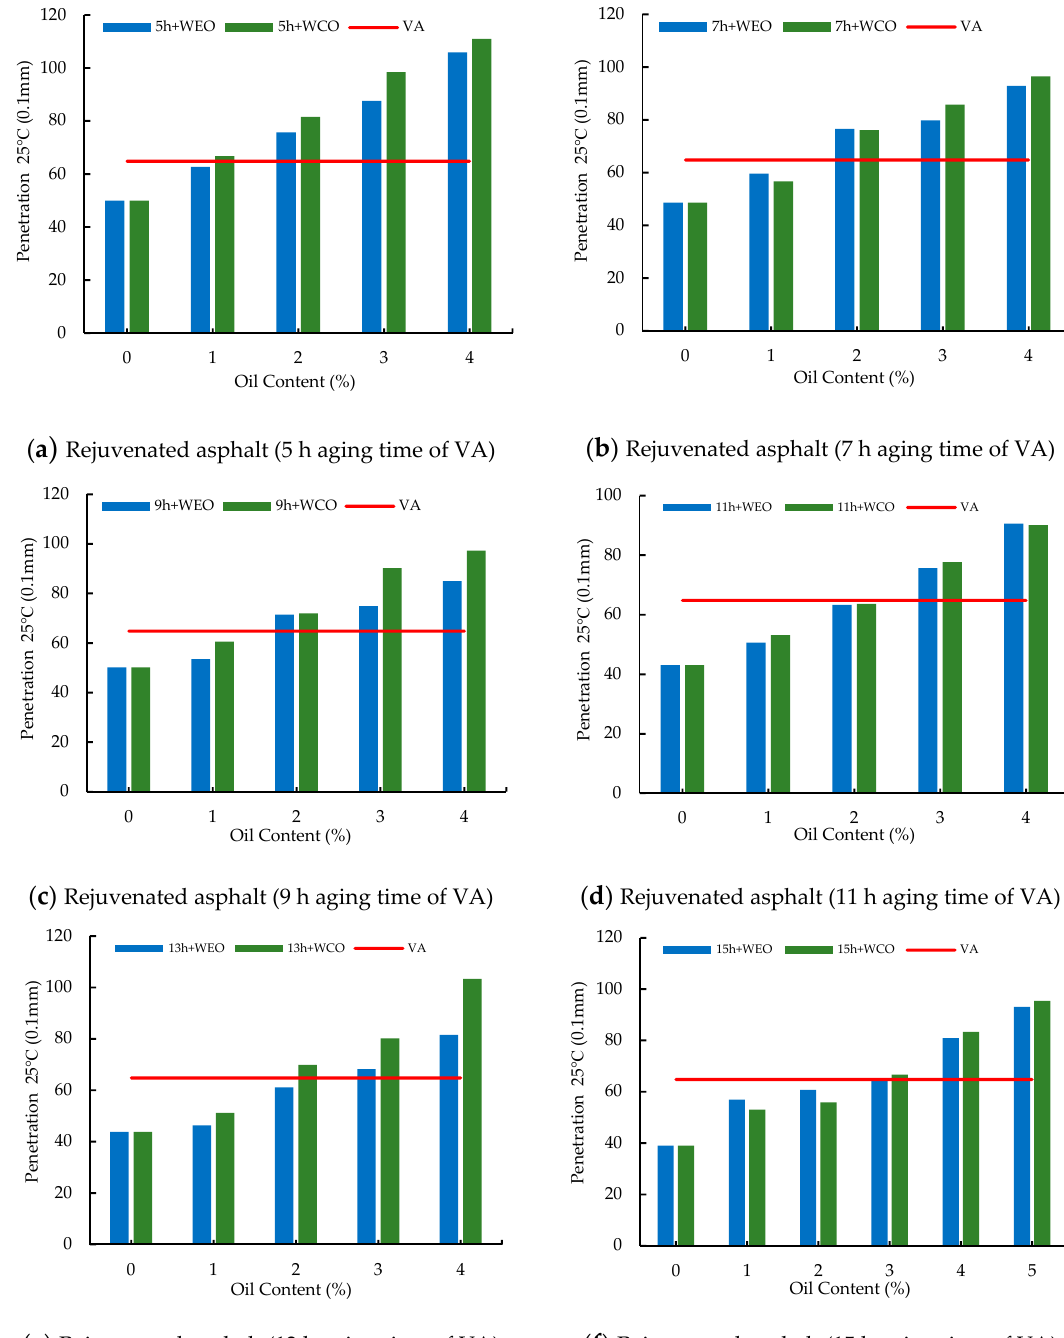
Figure 6. Effects of WEO or WCO on penetration of different aged asphalt. Figure 6. E ff ects of WEO or WCO on penetration of di ff erent aged